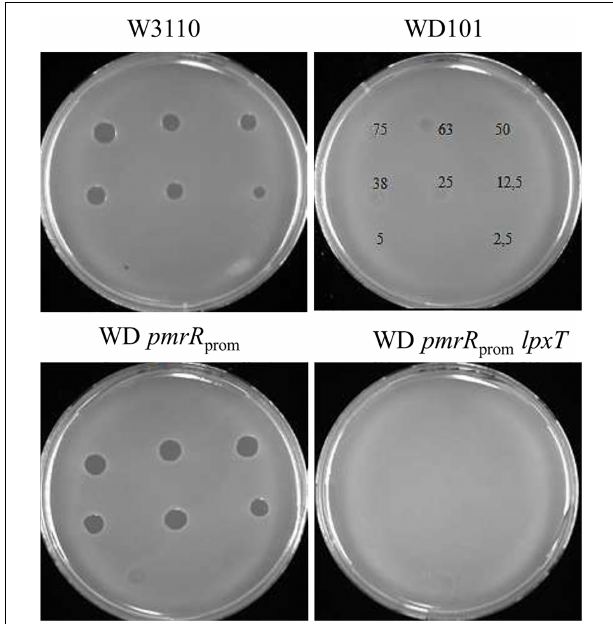
FIGURE 8 | Phenotypic analysis of WD pmrR prom strain and derivatives. 5- µ l spots containing various amounts of polymyxin B (from 2.5 to 75 ng) were deposited on lawns of W3110, WD101, WD pmrR prom , and WD pmrR prom lpxT strains. Growth inhibition zones were observed after 16 h of incubation at 37 ◦ C. The data are representative of at least three independent experiments.